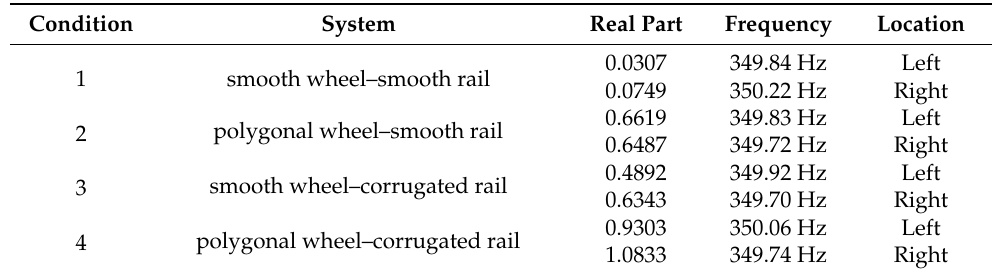
Table 1. Friction coupling vibration characteristics of the system under different wheel–rail contact